Question: What kind of plot is shown here?
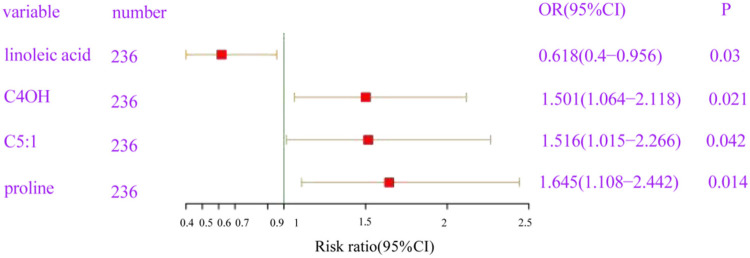
Answer: forest